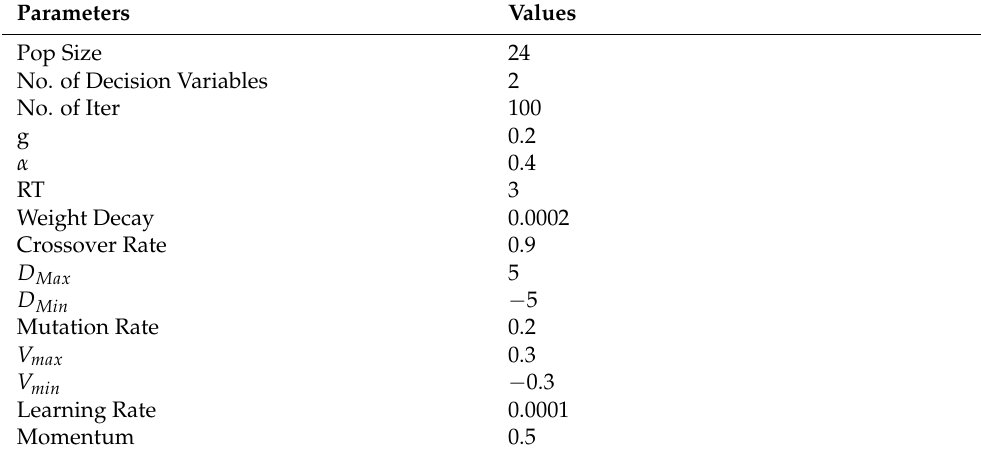
Table 3. GWDO parameter